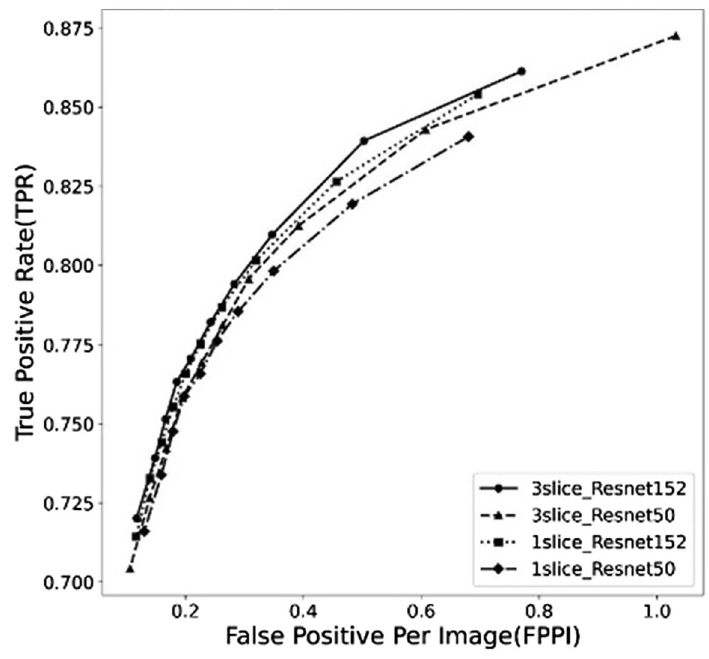
Figure 3. Free response operating characteristic curves of results from the models using proposed three slice data and one slice data based on ResNet152 and ResNet50 backbones, respectively.